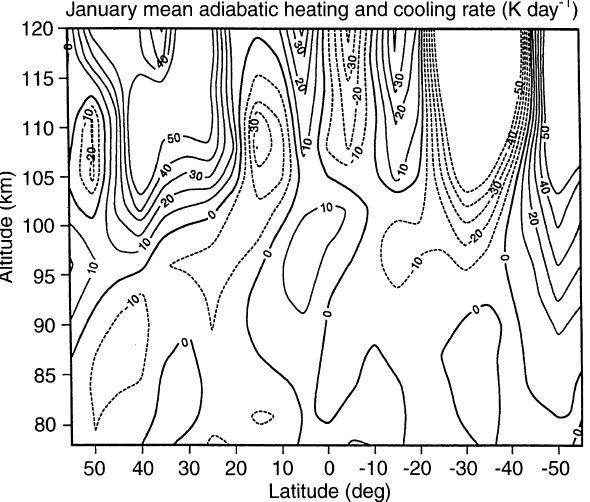
Fig. 14. Latitude-height distribution of the mean adiabatic heating and cooling rate in